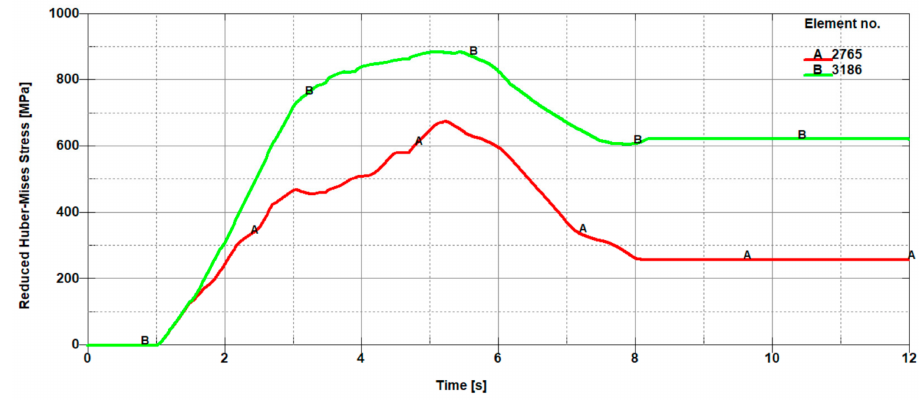
Figure 12. Mean reduced Huber–Mises stresses from the front (A 2765) and from the back (B 3186) of a cutting tool, which correspond to finite element numbers 2765 and 3186, respectively (Figure 11).